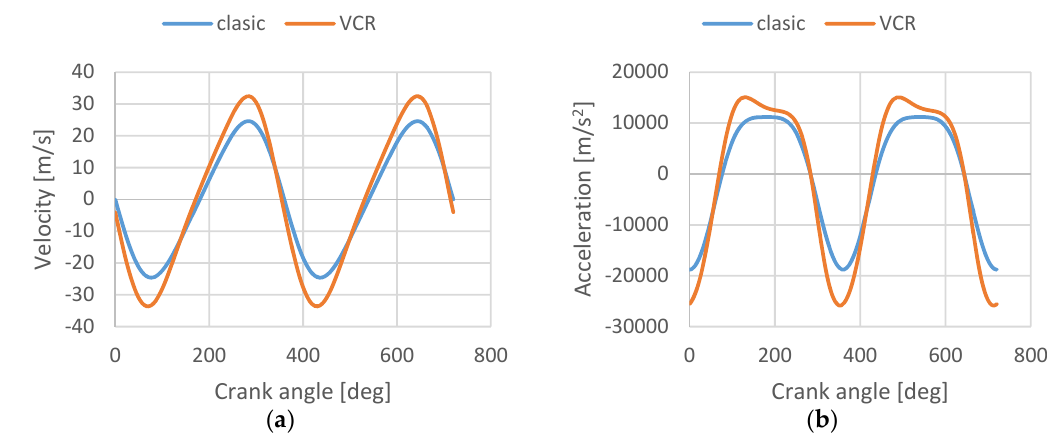
Figure 7. Kinematic parameters evolution on a complete cycle rotation crankshaft: ( a ) piston velocity; ( b ) piston acceleration.